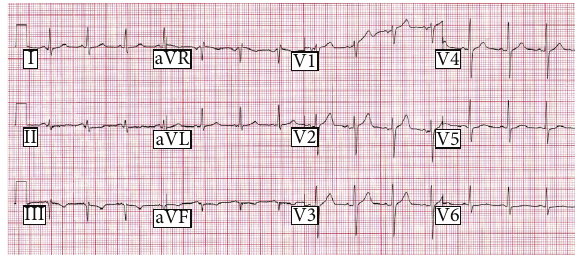
Figure 2: 12-lead electrocardiagram of the deceased’s father. The ST- T segment is unusual and very flat in lead II, such that determining the end of the T wave is difficult. In lead I, R-R is 690 ms, QT is 396 ms, and QTc is 477 ms. In lead V5, R-R is 711ms, QT s 391ms, and QTc is 464 ms; the T wave is of low amplitude with a slight double bump